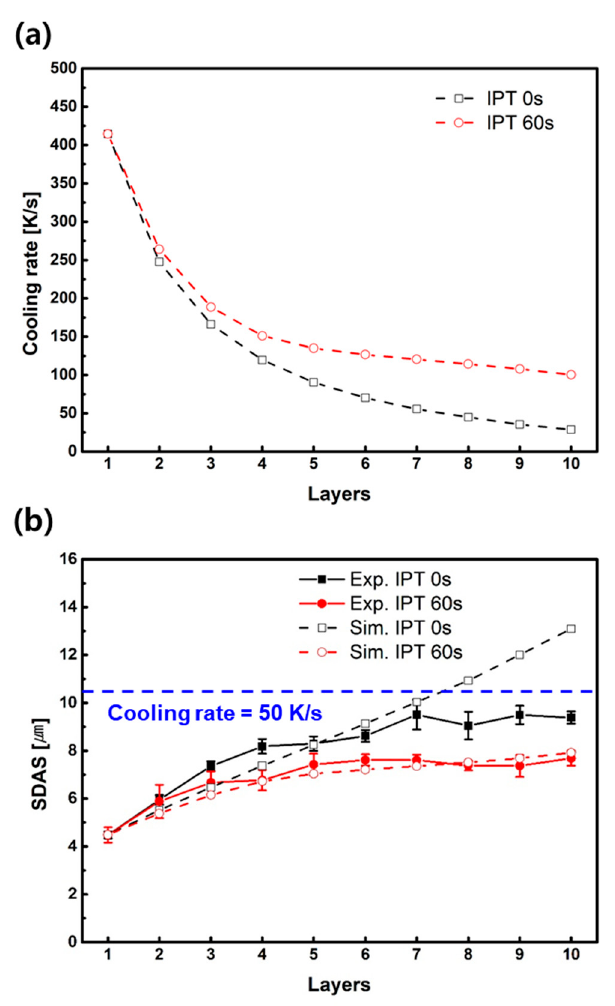
Figure 9. Relationship between the cooling rate and SDAS under IPTs of 0 s and 60 s: ( a ) Simulated cooling rate, and ( b ) measured (experiment) and simulated SDAS (simulation).